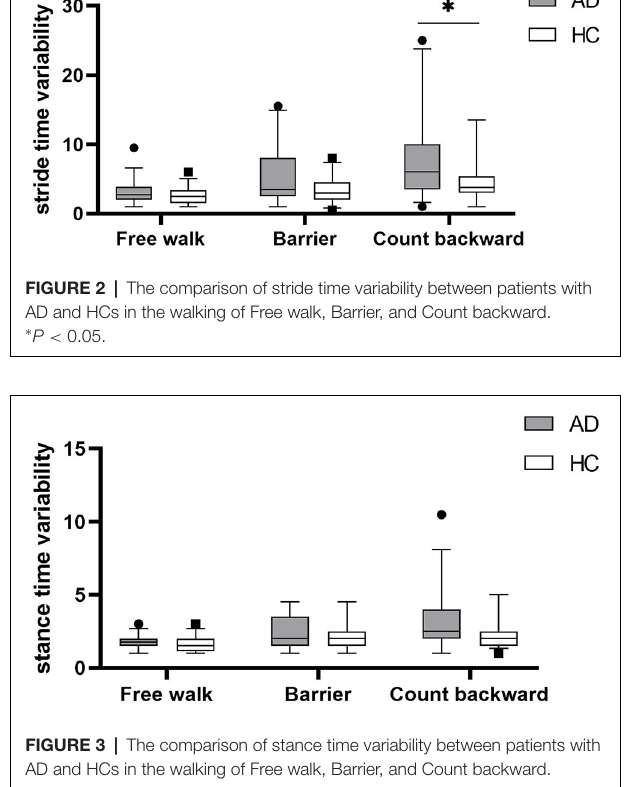
three walking tests, but correlated with gait variability only in the walking tests without much cognitive